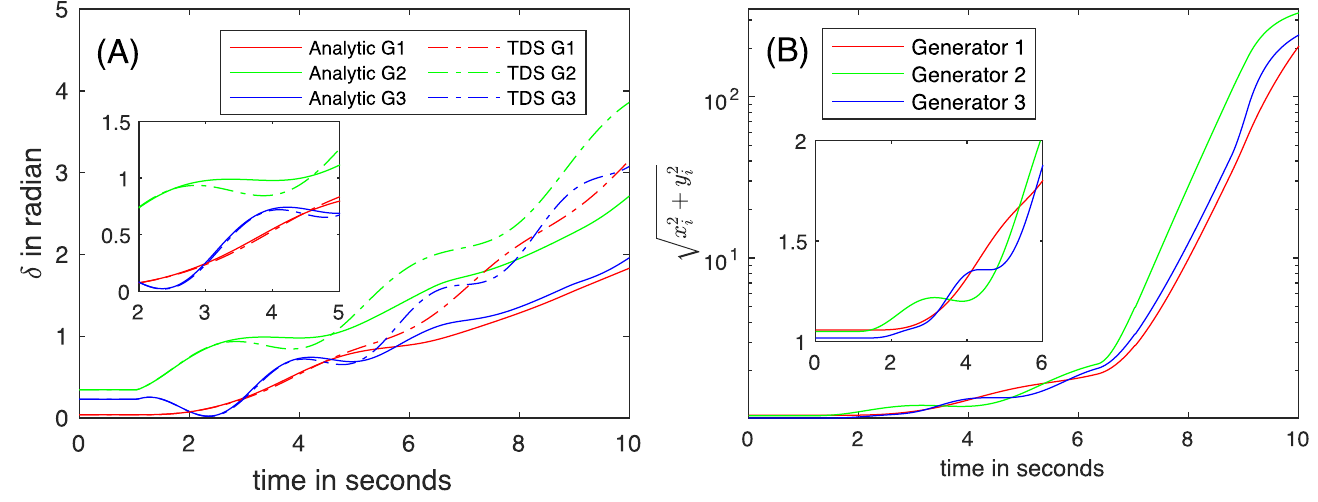
Fig 9. (A) Post-fault trajectories of the rotor angles and (B) the magnitudes of the estimated internal